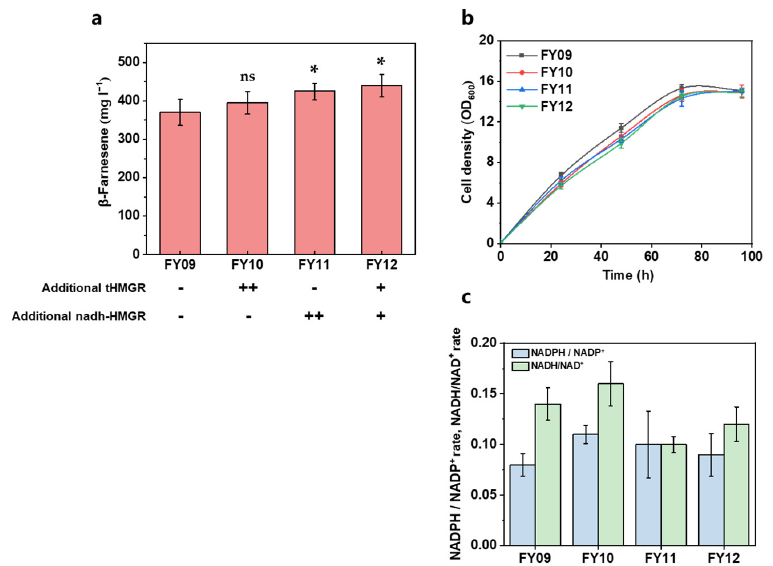
Figure 4. Further overexpression of rate-limiting enzyme HMG-CoA reductase. ( a ) β -Farnesene production by expression of additional copies of NADH or NADPH-dependent HMG-CoA reduction and ( b ) cell density. ( c ) Intracellular NADPH/NADP+ and NADH/NAD+ ratios. β -Farnesene was detected at 96 h of fermentation. Each black plus sign represents a copy. Data are represented as mean ± standard deviation (n = 3). Statistically significant differences between each engineered β -farnesene production strain and control strain (NC) are noted (two-tailed t -test; ns—not significant; * p < 0.05).